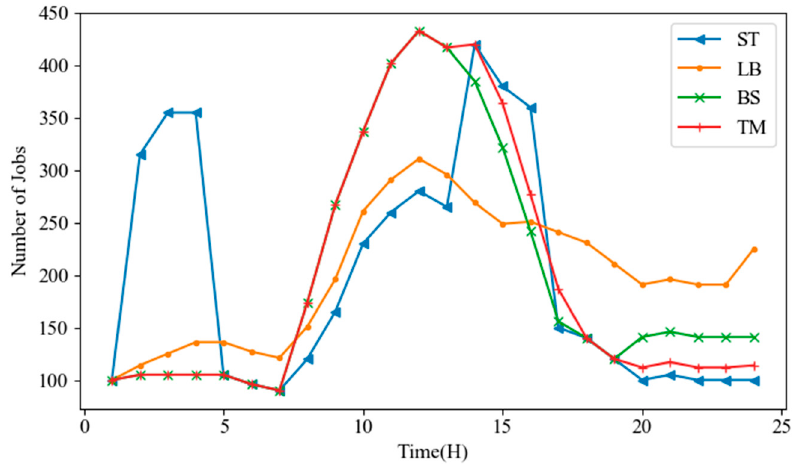
Figure 8. Comparison of job scheduling under the four policies.